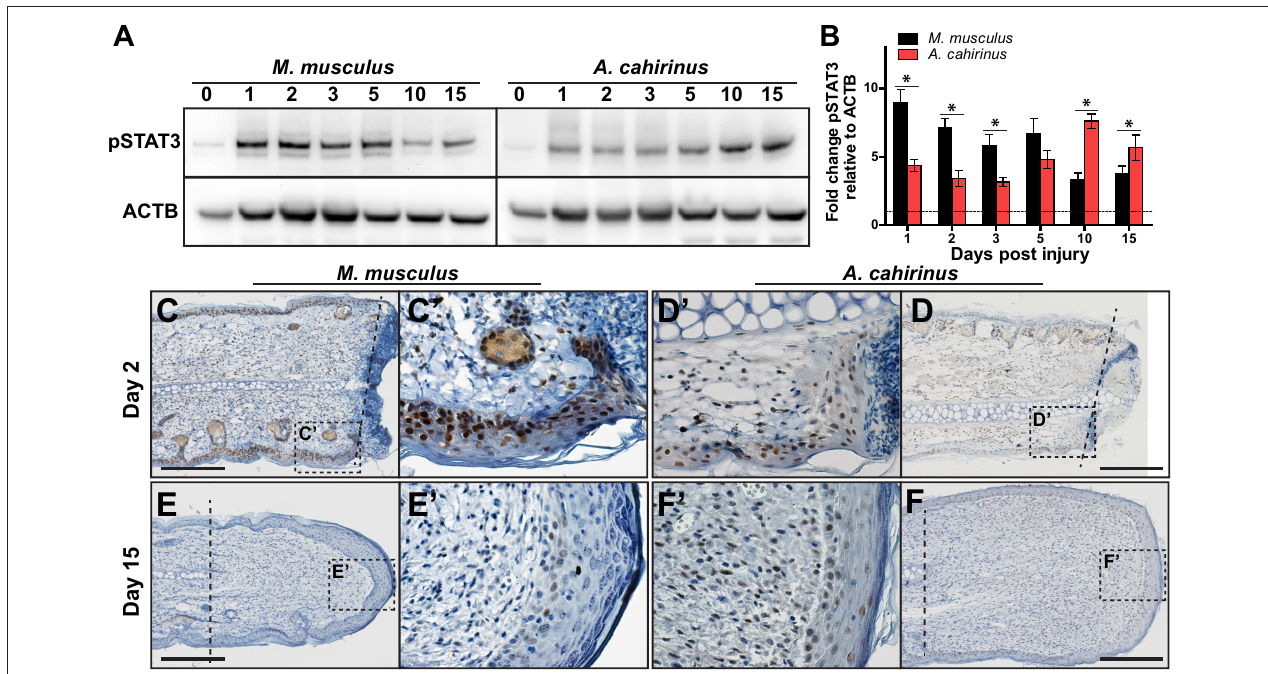
FIGURE 5 | Time-dependent STAT3 activation in the blastema is associated with regeneration. (A) Comparison of representative immunoblots for pSTAT3 and ACTB for indicated time and species from injured tissue homogenate from ear-hole punch assay. Representative immunoblot images showing bands used for quantification (pSTAT3 80 and 86 kDa and ACTB 45 kDa). (B) Fibrotic repair is associated with strong early STAT3 activation while regeneration is associated with a weak early ∼ ∼ and strong postponed activation. Data represent mean fold change of pSTAT3 intensity normalized to ACTB intensity and relative to D0 and S.E.M. n 4 individuals = per time point and species (B) . (C–F ′ ) Representative immunohistochemistry images for pSTAT3 (DAB brown) counterstained with hematoxylin (blue) for M. = musculus (C ′ ,E ′ ) and A. cahirinus (D ′ ,F ′ ) at the indicated time points. On D2 after injury, nearly every epidermal cell in M. musculus was positive compared to about half in A. cahirinus (C,D) . On D15, only a small population of epidermal cells in M. musculus were positive compared to about half in A. cahirinus (E,F) . Additionally, about half of the blastema cells were positive at D15 (F ′ ) . Data represent n 3. Scale bar 200 µ m. = =